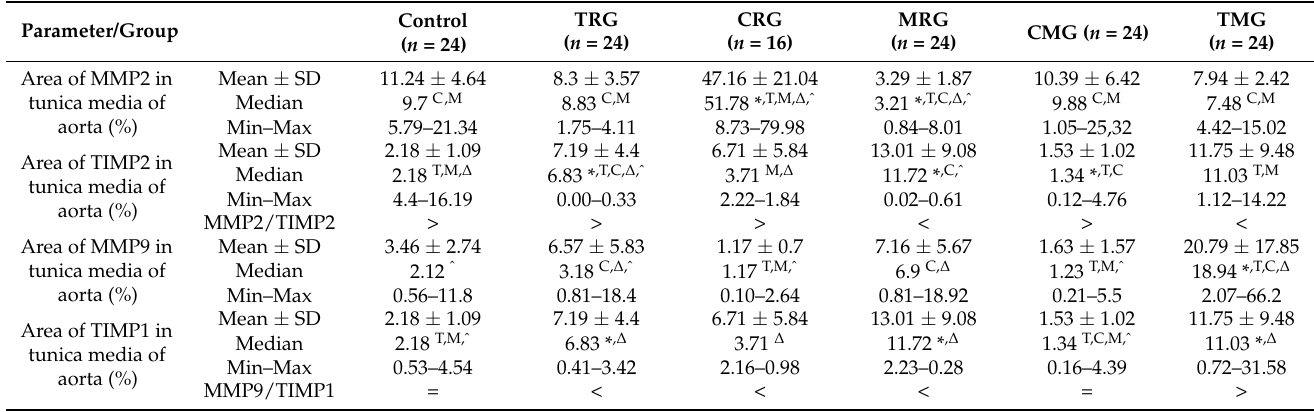
Table 4. The expression MMP-2 and MMP-9, and their inhibitors—TIMP-2 and TIMP-1 in tested groups. Relations between MMPs expression and their inhibitors in relation to maintaining equilib- rium or